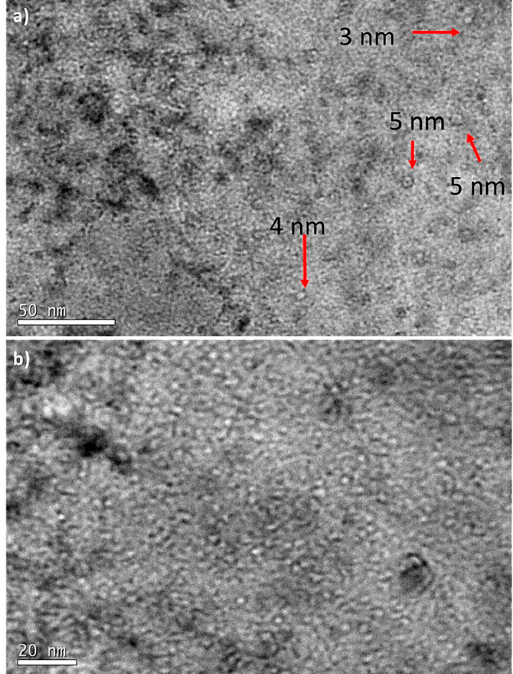
Figure 15. TEM micrograph representative of zone C (518 to 445 appm He) of EU-ODS EUROFER steel annealed at 450 ◦ C for 100 h showing ( a ) very few medium size cavities and ( b ) the overall distribution of small cavities.